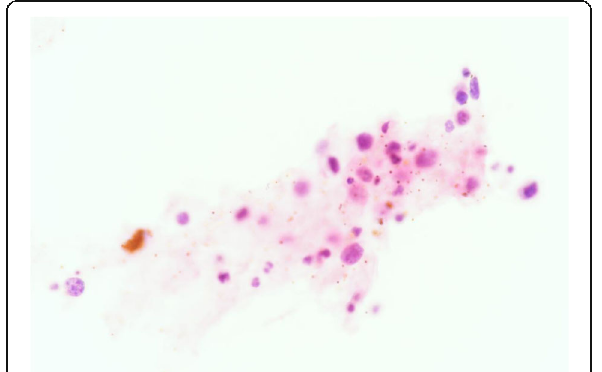
Fig. 6 Photomicrograph of vitreous biopsy (hematoxylin-erosin; × 40) showed small malignant